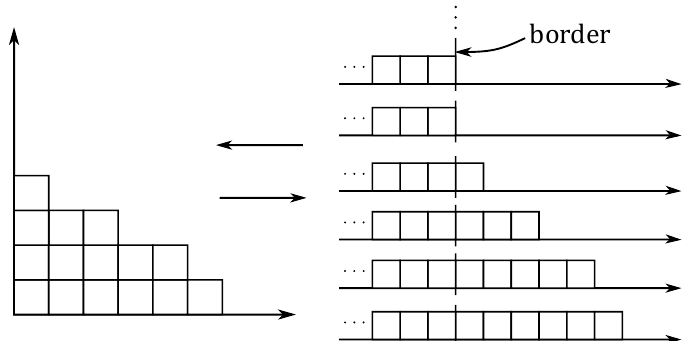
Figure 2. Two-dimensional crystal and one-dimensional crystal for C 3 -geometry. Each layer of the two-dimensional crystal can be understood as a one-dimensional crystal by extending it left to the border. By taking tensor products of these one-dimensional crystal representations, we obtain the two-dimensional crystal